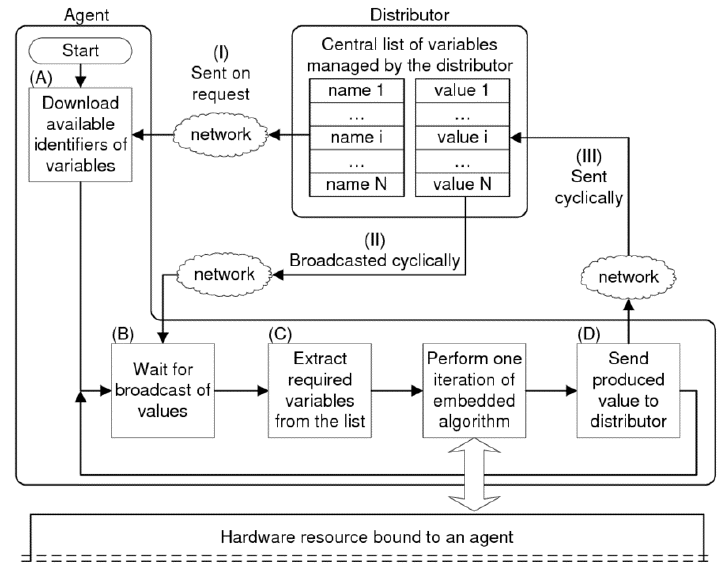
Fig. 1 The environment structure diagram of an